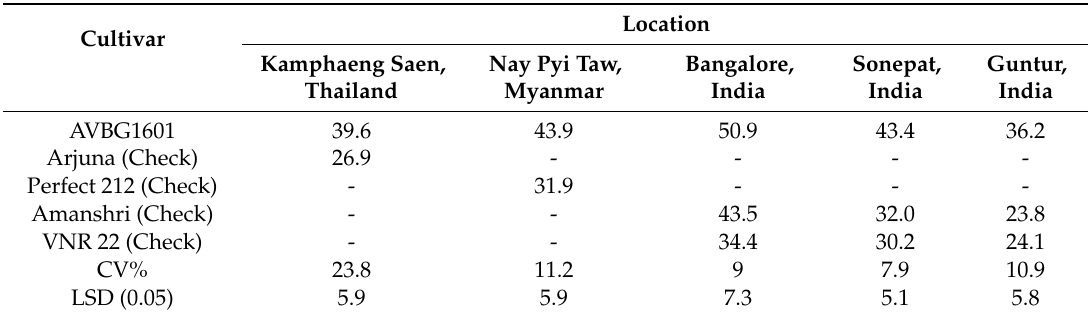
Table 2. Fruit yield (t ha − 1 ) of WorldVeg bitter gourd F 1 hybrid AVBG1601 and local checks evaluated in four locations across Southeast and South